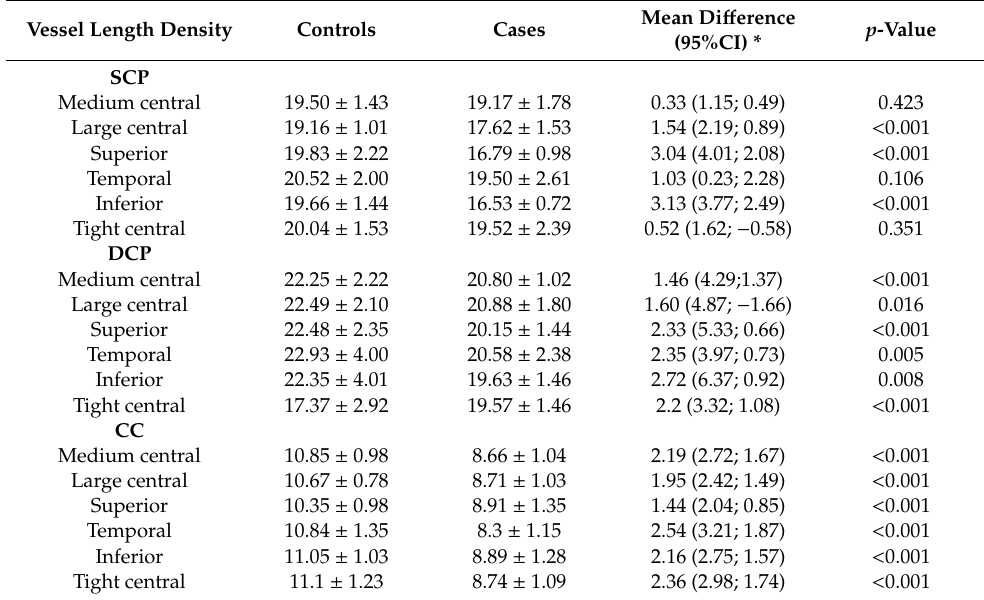
Table 5. Vessel length density values in cases and